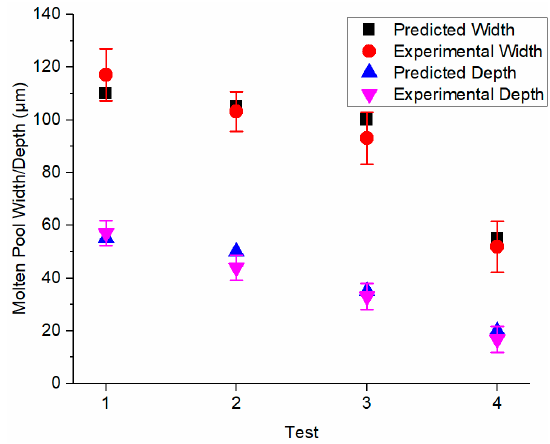
Figure 8. Comparison between predicted molten pool evolution using powder material properties with consideration of heat transfer boundary conditions (solid lines) and predicted molten pool evolution using solid bulk material properties without consideration of heat transfer boundary conditions (dashed lines).